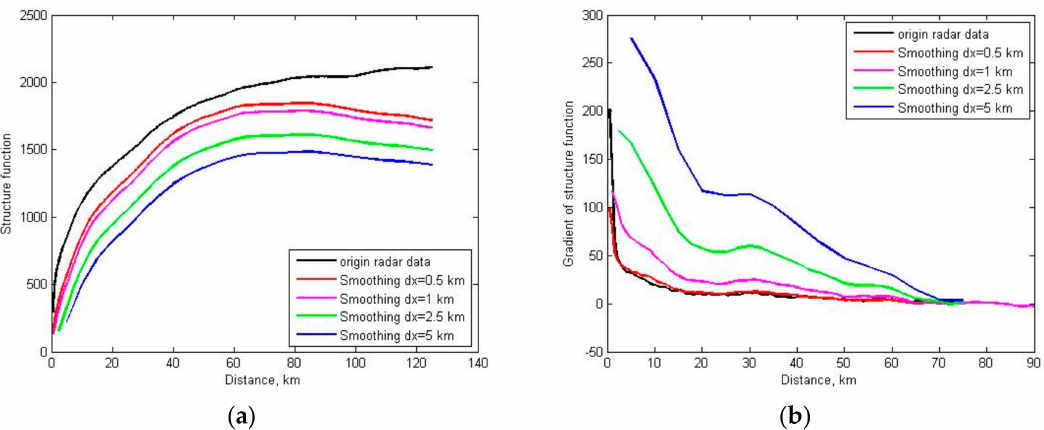
Figure 1. ( a ) Structure functions and ( b ) their gradients of radar reflectivity measurements for original data and after pre-processing with various smoothing